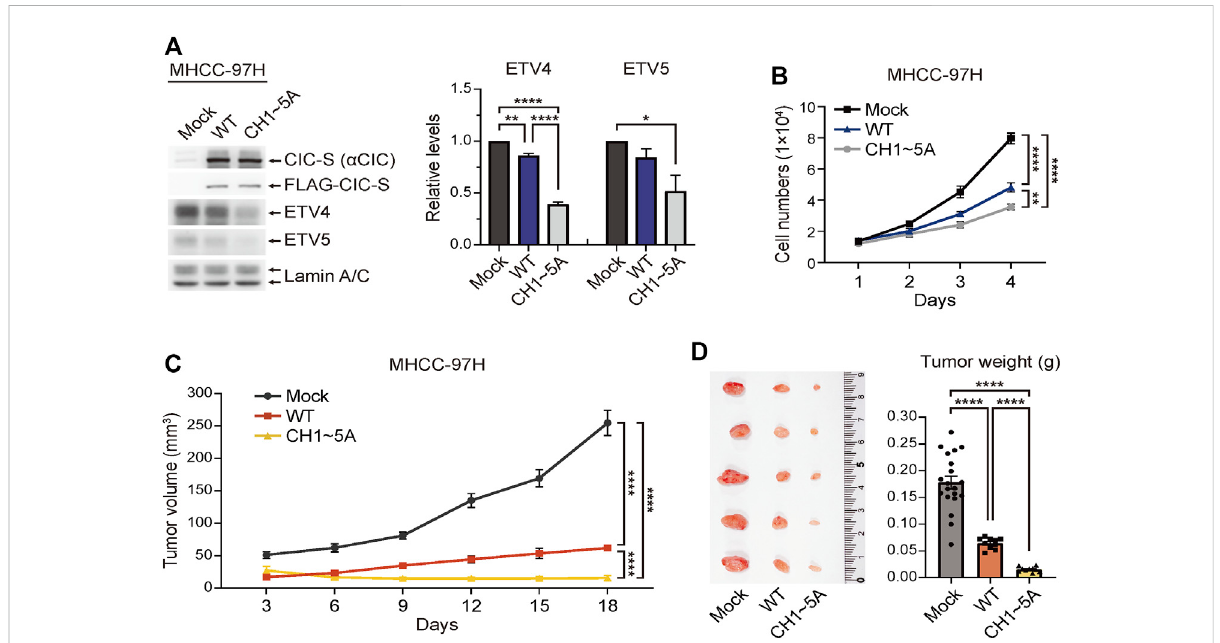
FIGURE 4 EnhancedtumorsuppressoractivityofFLAG-CIC-S CH1~5A . (A) WesternblottingwasperformedtodeterminetheexpressionlevelsofFLAG-CIC- S, ETV4, and ETV5 in MHCC-97H cells stably expressing FLAG-CIC-S WT or FLAG-CIC-S CH1~5A . The right panel is a bar graph for the relative level of ETV4 and ETV5. Three independent experiments were performed. Error bars indicate SEM. * p < 0.05, ** p < 0.01, and **** p < 0.0001. (B) In vitro cell growth assay for mock, FLAG-CIC-S WT -, and FLAG-CIC-S CH1~5A -expressing MHCC-97H cell lines. Cells were counted using a hemacytometer every 24 h for 4 days. Error bars represent SEM. n = 8 per group. ** p < 0.01 and **** p < 0.0001. (C,D) In vivo tumor growth assay using xenograft mouse models. Tumor (C) growth curves and (D) weights of nude mice inoculated with mock, FLAG-CIC-S WT -, and FLAG-CIC-S CH1~5A